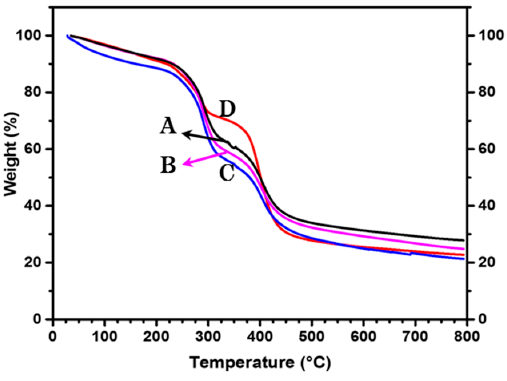
Figure 3. Thermogravimetric analysis (TGA) curves of ( A ) G/PANI/FG1; ( B ) G/PANI/FG2; ( C ) G/PANI/FG3; and ( D ) PANI/GNG. ( C ) G/PANI/FG3; and ( D )